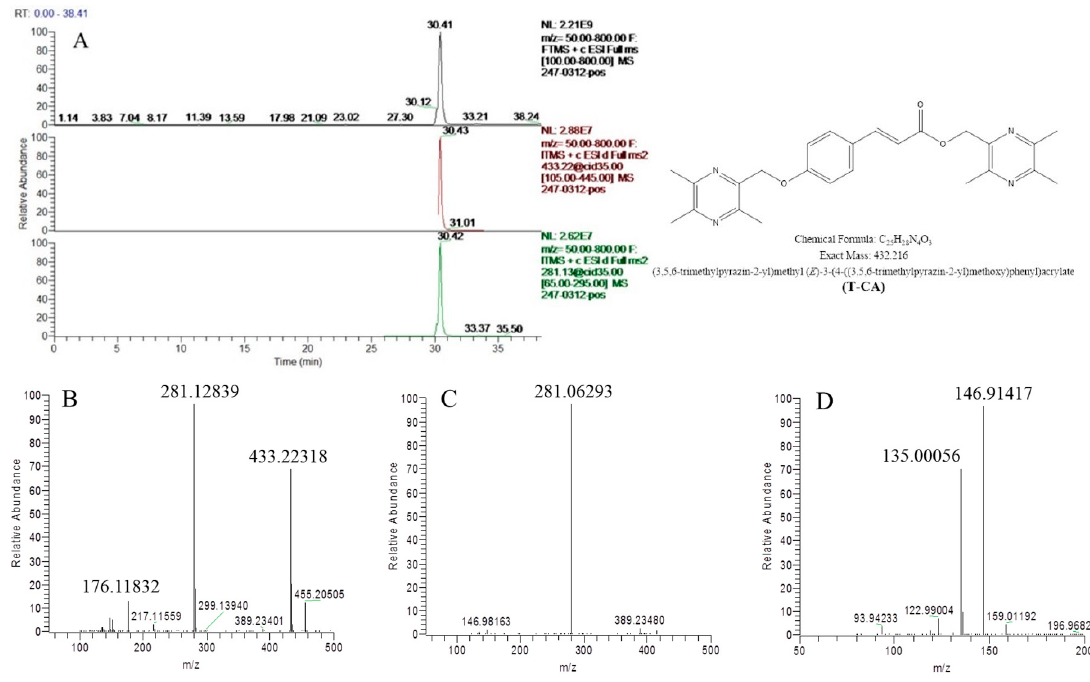
Figure 1. ( A ) Ion current chromatogram of (3,5,6-Trimethylpyrazin-2-yl)methyl(E)-3-(4-((3,5,6- trimethylpyrazin-2-l)methoxy)phenyl)acrylate (T-CA); ( B ) first-order full-scan mass spectrometry of T-CA; ( C ) secondary cleavage mass spectrometry of m / z 433.22318; ( D ) secondary cleavage mass spectrometry of m / z 281.06293.